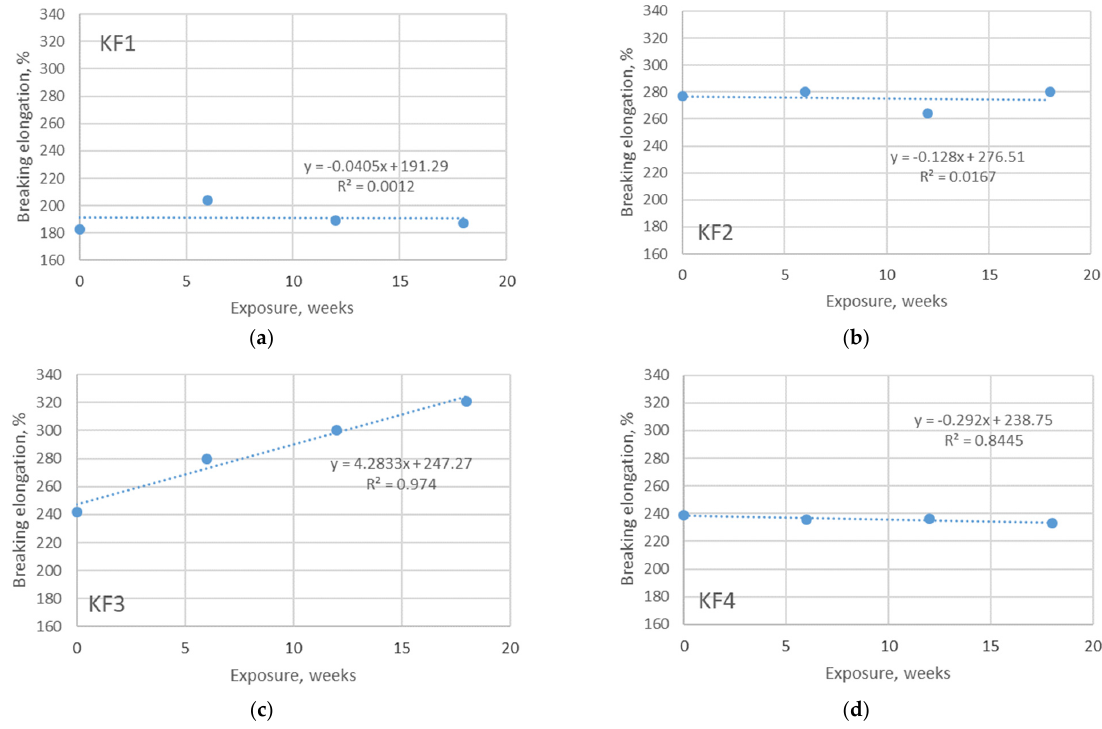
Figure 8. Breaking elongation of materials exposed to aging in pool water, indoors. The overview is given for: ( a ) material